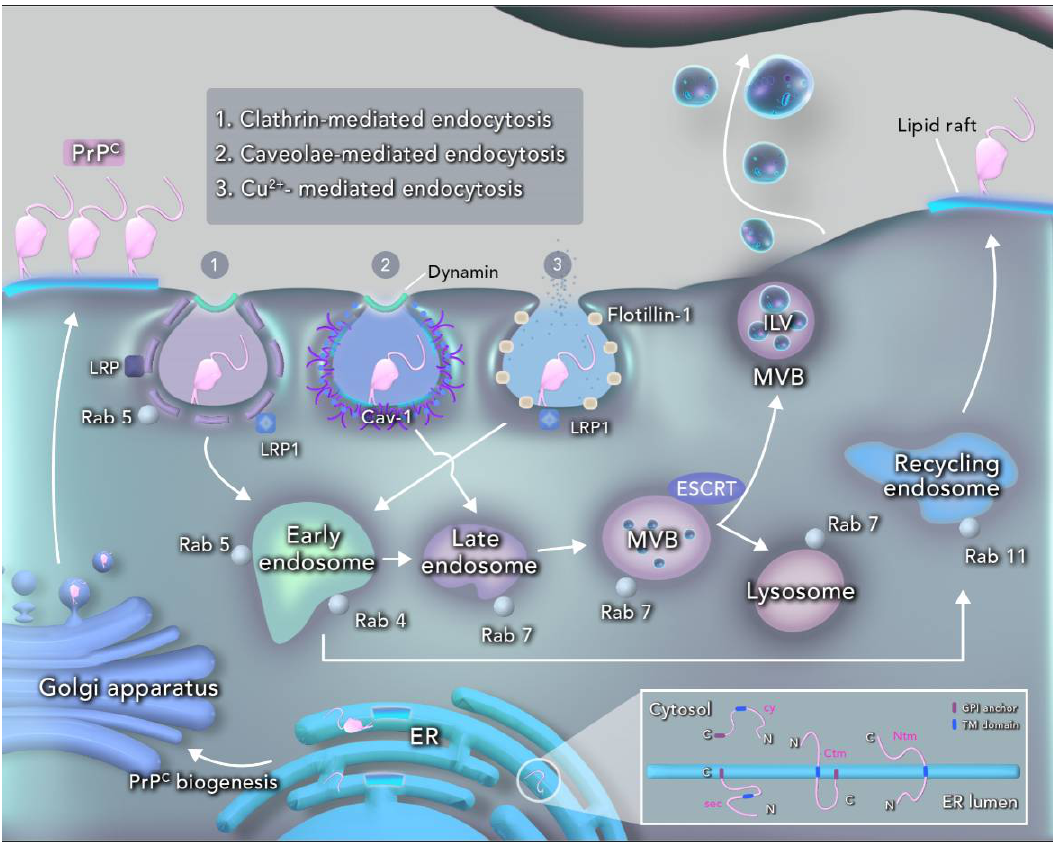
Figure 1. Biogenesis, location and endocytic trafficking of PrP C . PrP C translocation to the ER may